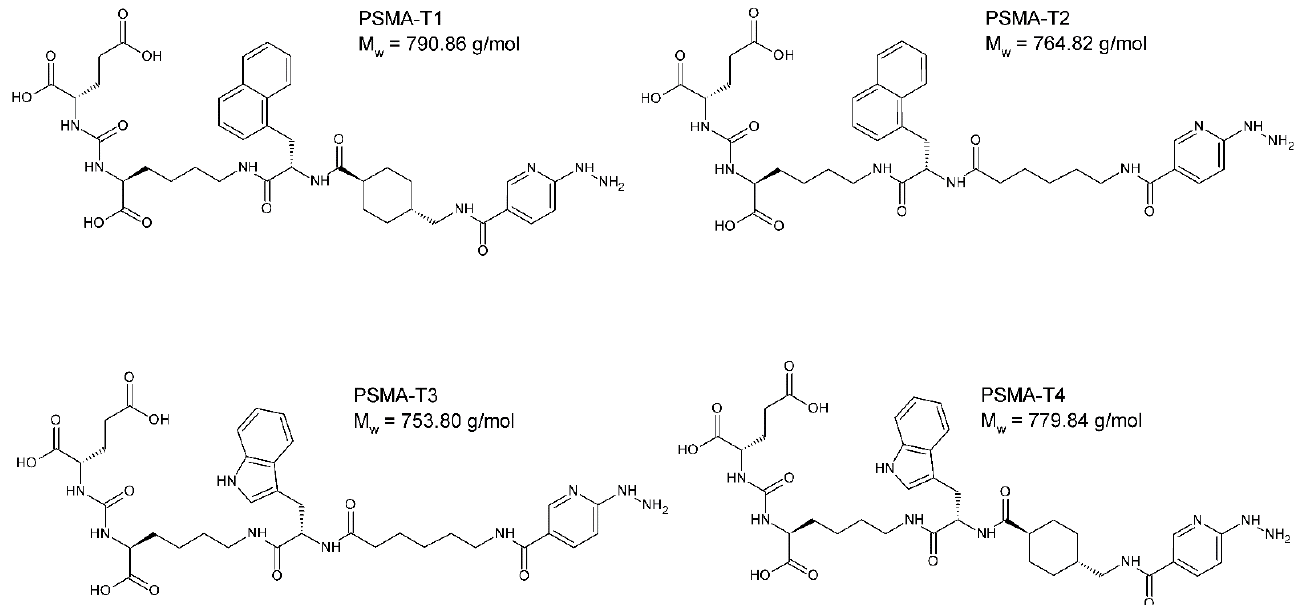
Figure 1. The chemical structure of PSMA ligands: PSMA-T1: Glu-CO-Lys-L2NaI-6Ahx-HYNIC,